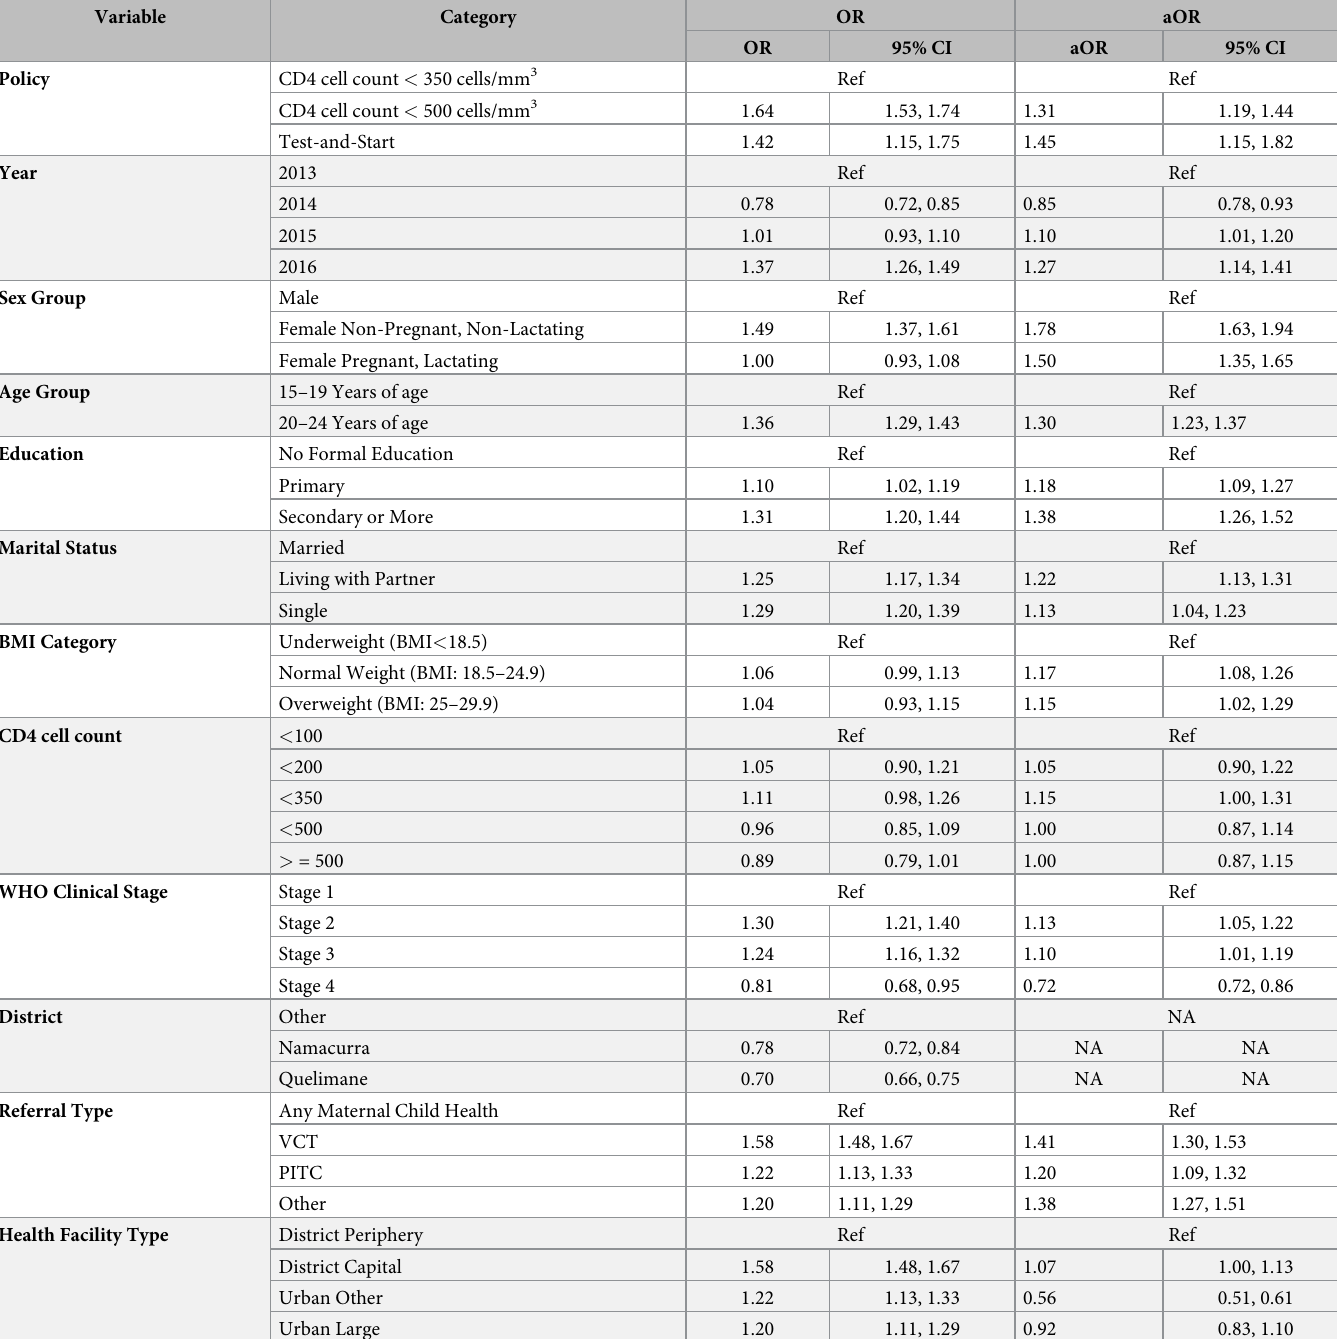
Table 4. Odds of being retained in care one year after ART initiation + .